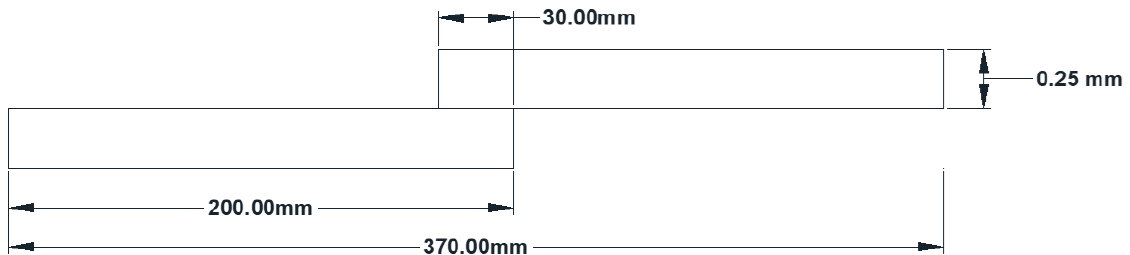
Figure 1. ASTM F1684 thin plate lap joint welding test piece schematic diagram.